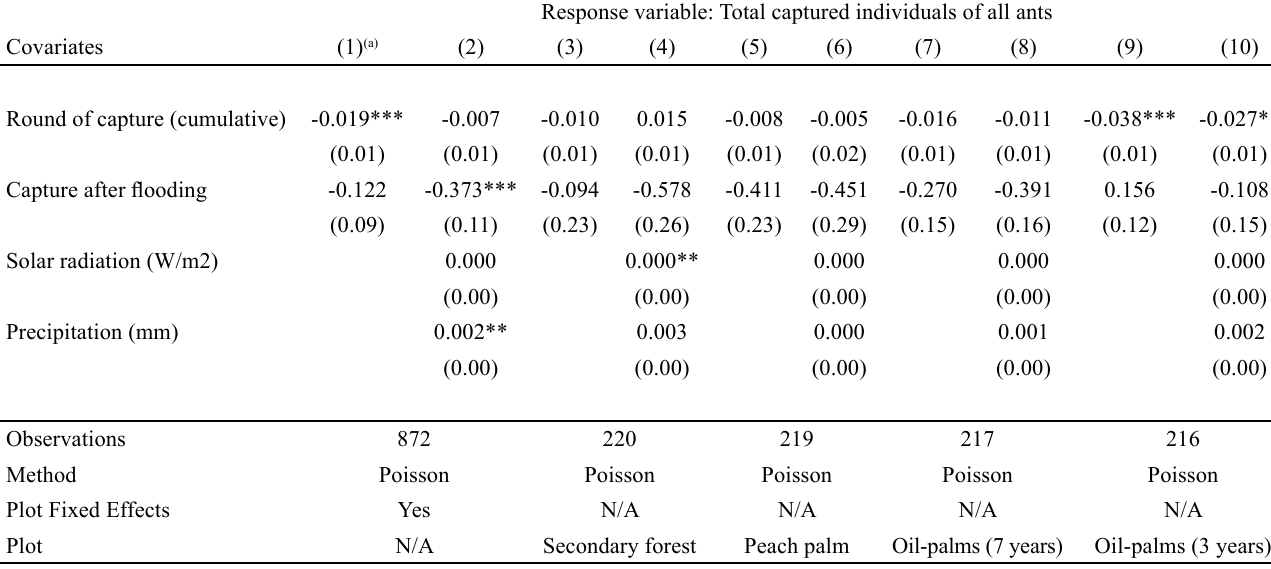
Table 6 . Estimated effect of pitfall trapping over all ants by Negative Binomial (NB2) regression